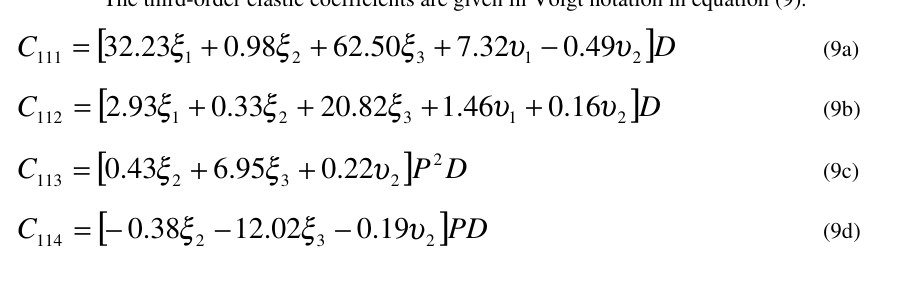
The third-order elastic coefficients are given in Voigt notation in equation